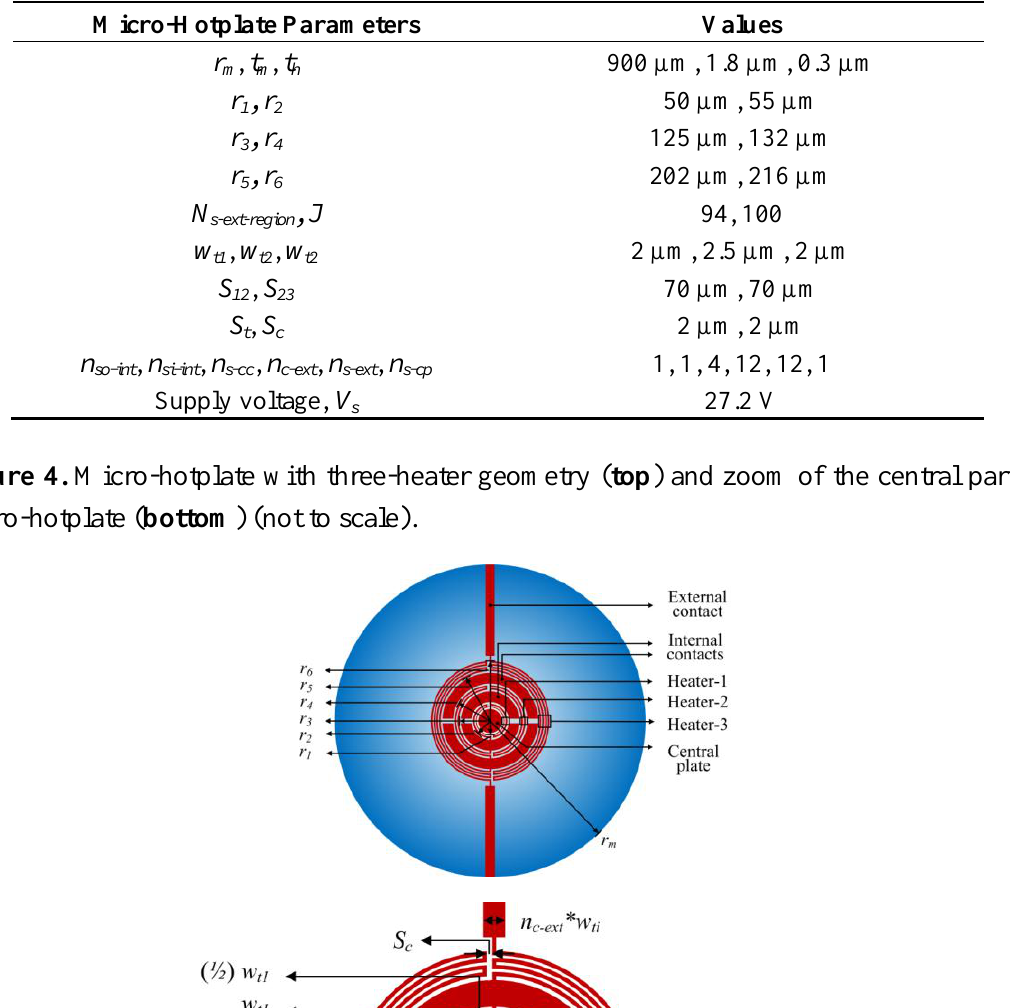
Table 2. Micro-hotplate parameters.